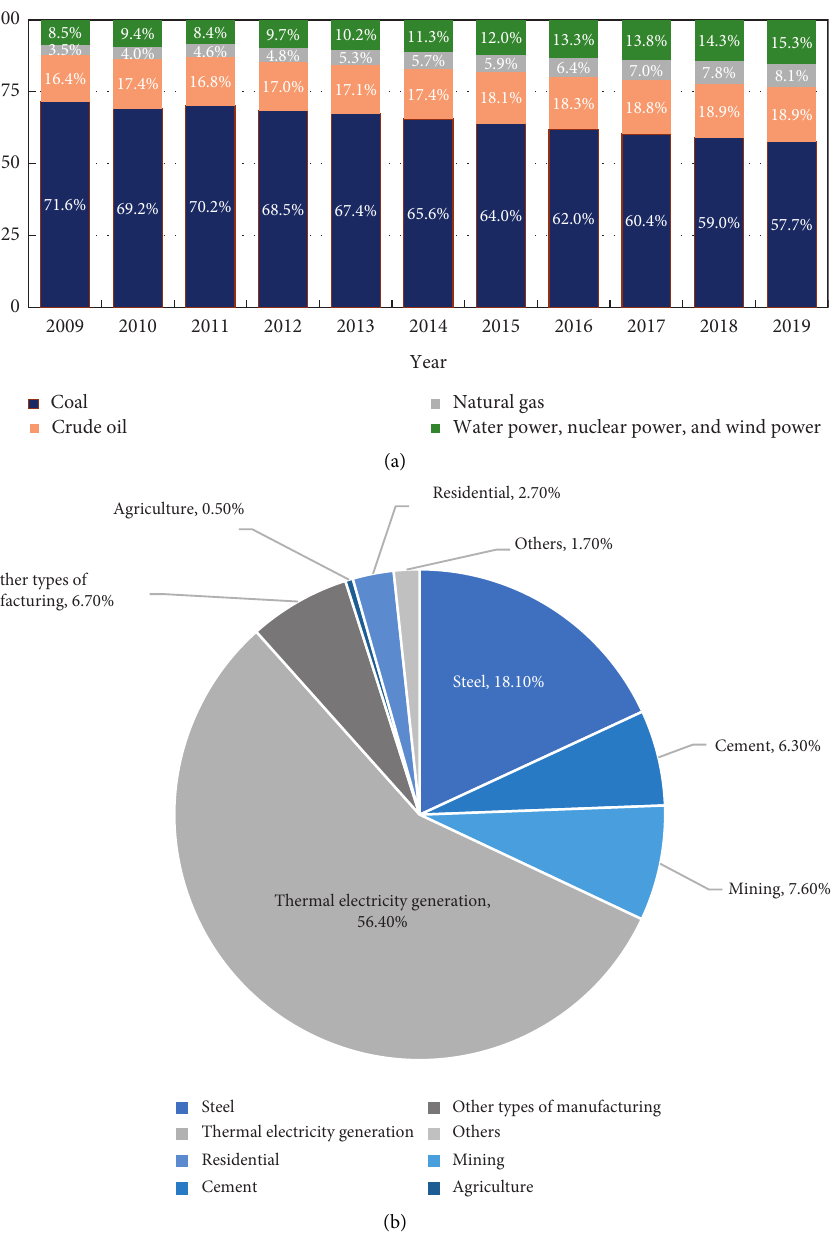
Figure 11: Energy consumption in China. (a) China’s energy consumption by source (data source: Samantha. W. Energy consumption in China from 2009 to 2019, by source . Available at https://www.statista.com/statistics/278669/energy-consumption-in-china-by-source/); (b) China’s coal consumption by end market in 2020 (Data source: National Bureau of Statistics. Available at